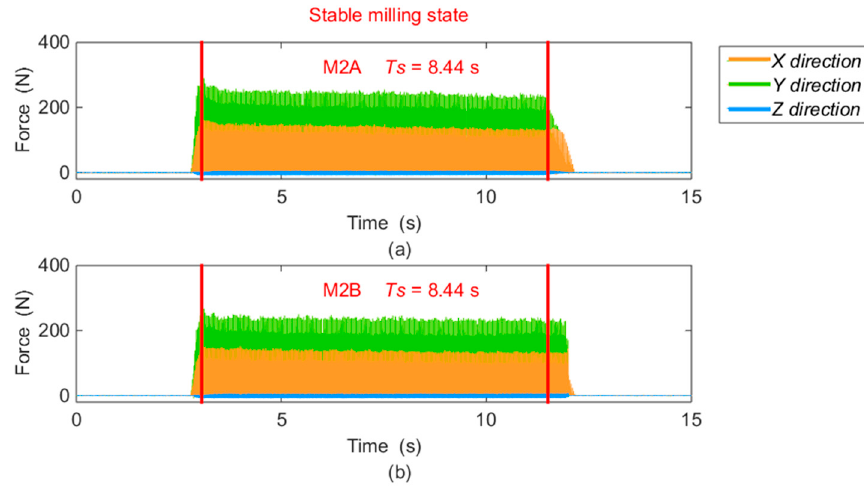
Figure 14. Milling forces from M2 in stable state: ( a ) data from M2A; ( b ) data from M2B. Table 5. The averaged peak to peak values of milling force in each group.